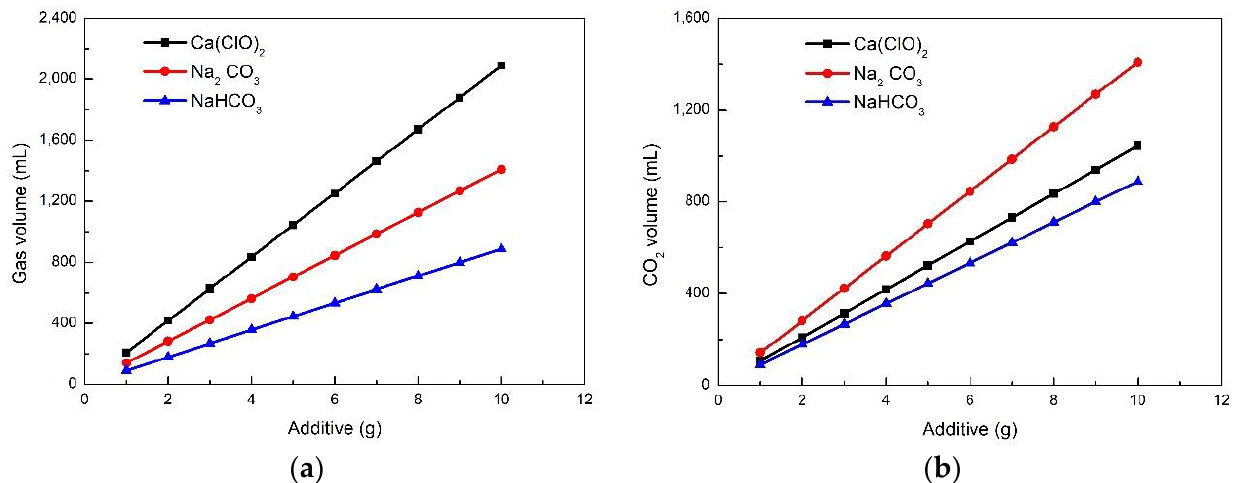
Figure 3. Effect of gas-generating agent addition on the volume of generated gas. ( a ) Gas volume. ( b ) CO 2 volume.